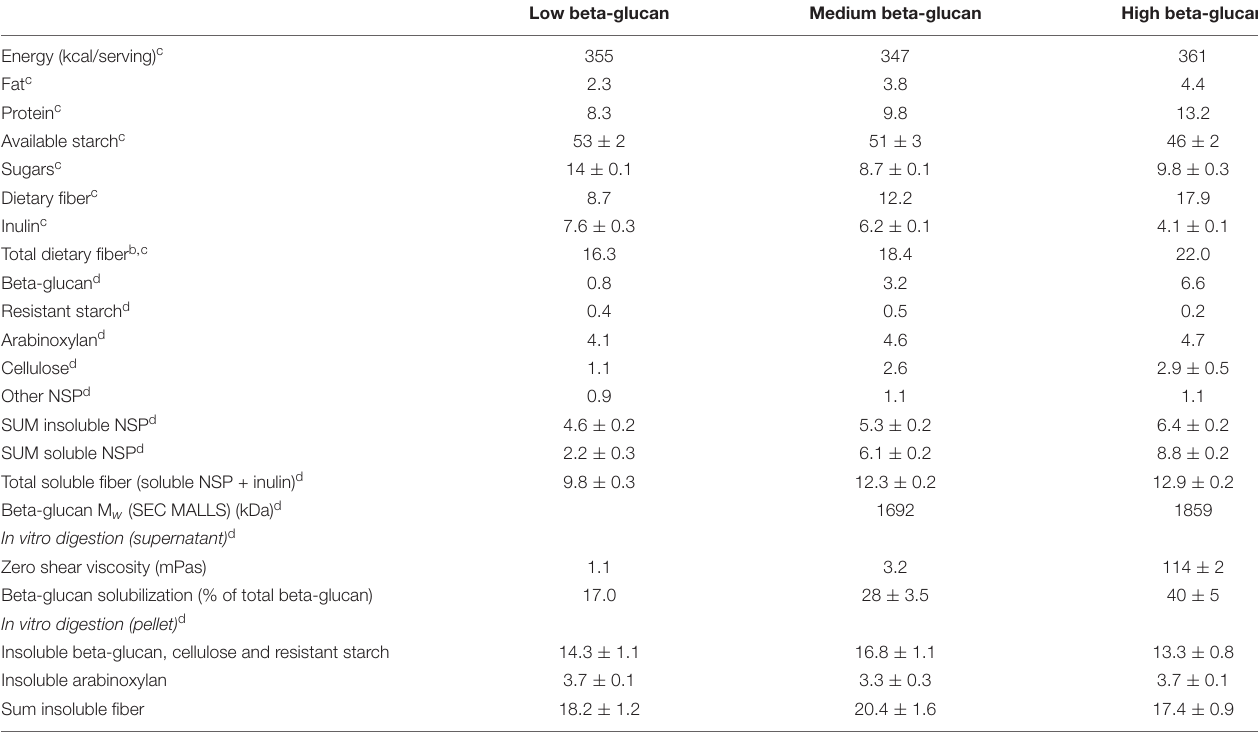
TABLE 1 | Macronutrient and chemical composition and properties of dietary fibers in the test meals with and without in vitro digestion a . Low